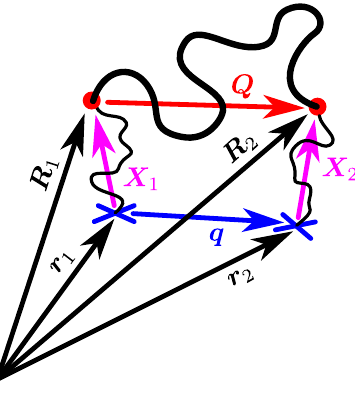
Figure 1. Sketch of single-strand network model on detailed level of description. The strand (thick black line) is attached to cross-links (red dots) connected to affinely moving anchors (blue crosses) by virtual springs (thin black lines). Position vectors and connector vectors are indicated by black and colored arrows,